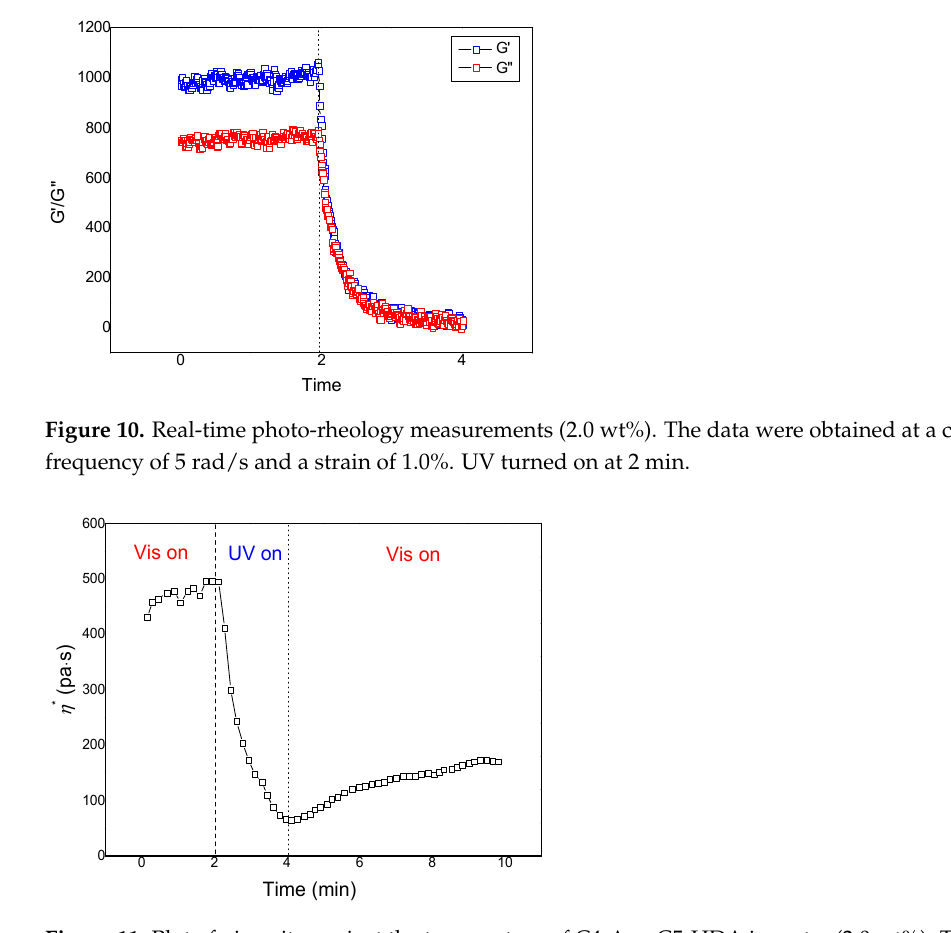
Figure 12. Human fibroblasts L929-supportive properties of the C4-Azo-C5-HDA hydrogels. After hydrogel swelling in culture medium for 24 h, L929 were seeded onto the hydrogels and incubated for 24 h: ( a ) bright field, ( b ) live cells on the hydrogel and ( c ) dead cells on the hydrogel. Supplementary Materials: The following are available online at www.mdpi.com/xxx/s1, Figure S1: 1 H NMR spectrum of compound 1 in CDCl 3 , Figure S2: 1 H NMR spectrum of compound 2 in CDCl 3 , Figure S3: 1 H NMR spectrum of C4-Azo-C5-HDA in CH 3 OH-d 4 , Figure S4: FTIR spectrums of com- pound 1, compound 2 and C4-Azo-C5-HDA. Author Contributions: Author Contributions: Y.W. and R.Y. designed the experiments; Y.W. and Y.L. performed the experiments; Y.W. analyzed the data; Y.W. wrote the original draft. J.C. and R.Y. revised the paper. All authors have read and agreed to the published version of the manuscript. Funding: This research was funded by the Project on the Integration of Industry, Education and Research of Jiangsu Province (Grant No. BY2021129).